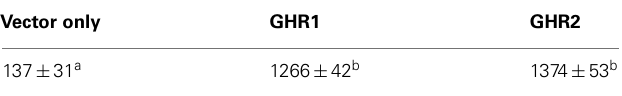
FIGURE 1 | Growth hormone (GH) activates multiple signal pathways via rainbow trout GH receptors (GHR) transfected in Chinese hamster ovary (CHO)-K1 cells. CHO-K1 cells were stably transfected with cDNA encoding rainbow trout GHR1 and GHR2. Cells were incubated with 100ng/ml salmonid GH for various times; after which, the cells were collected and lysed. Lysates were separated by SDS-PAGE followed by Western immunoblotting using phospho-specific (pERK 1/2, pAkt, pJAK2, pSTAT5) and total (tERK 1/2; tAkt, tJAK2, tSTAT5)